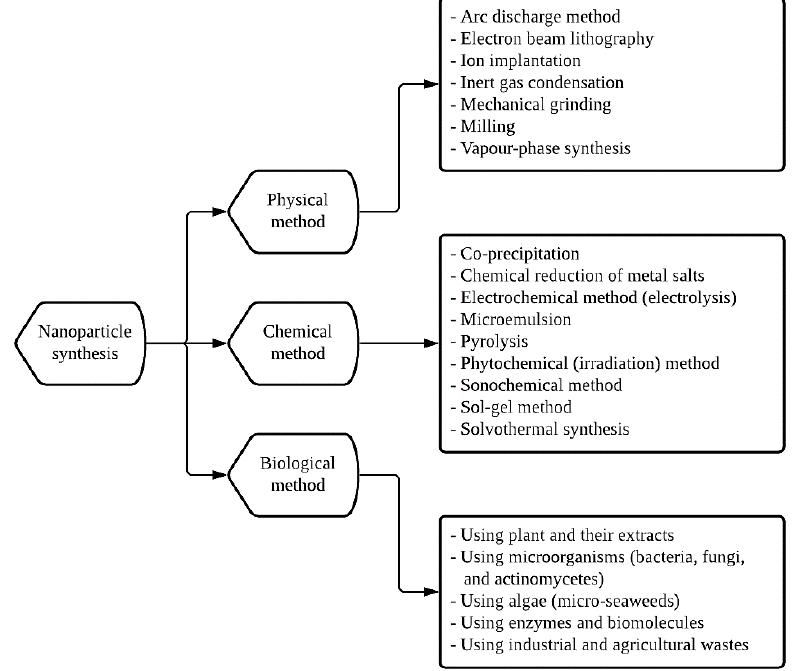
Figure 2. Classification of nanoparticle synthesis methods.